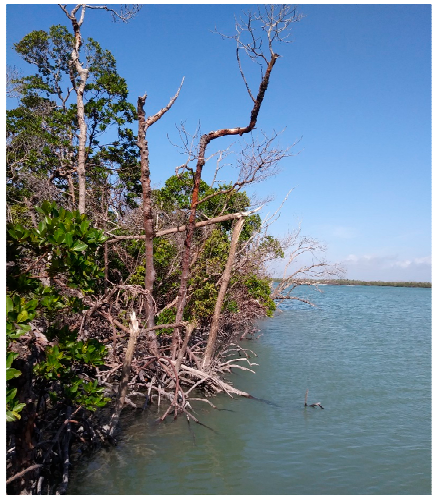
Figure 2. Photograph of broken and defoliated red mangroves from the January 2019 site visit.